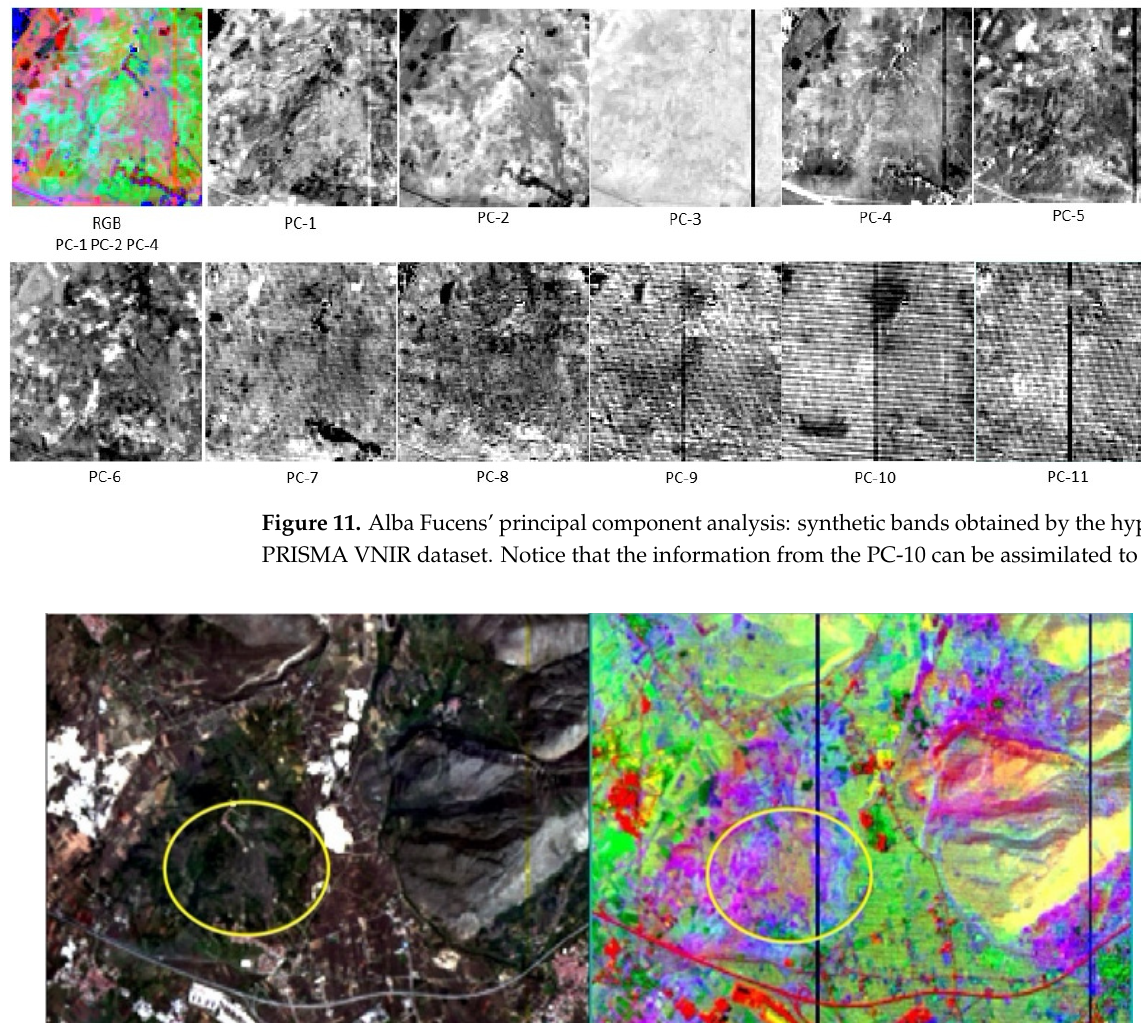
Figure 12. Alba Fucens’ PRISMA VNIR particular comparison referred to RGB (left) and PCA (right) image: in the highlighted central area it can be noted that the soil features are structurally different compared to the surrounding soils.